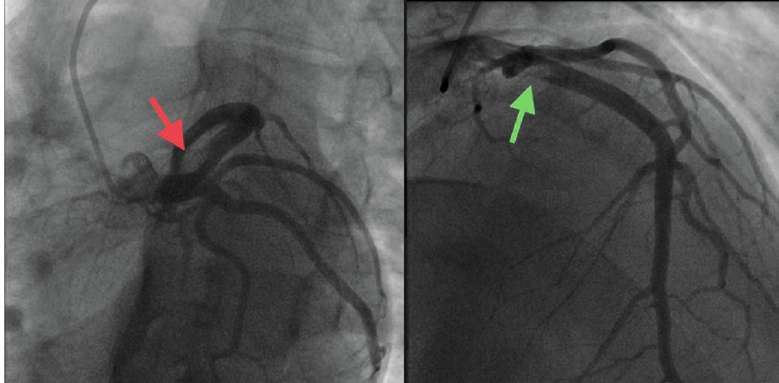
Figure 5: LAO caudal (red arrow) and RAO (green arrow) catheterization views of intramural fi lling defect of